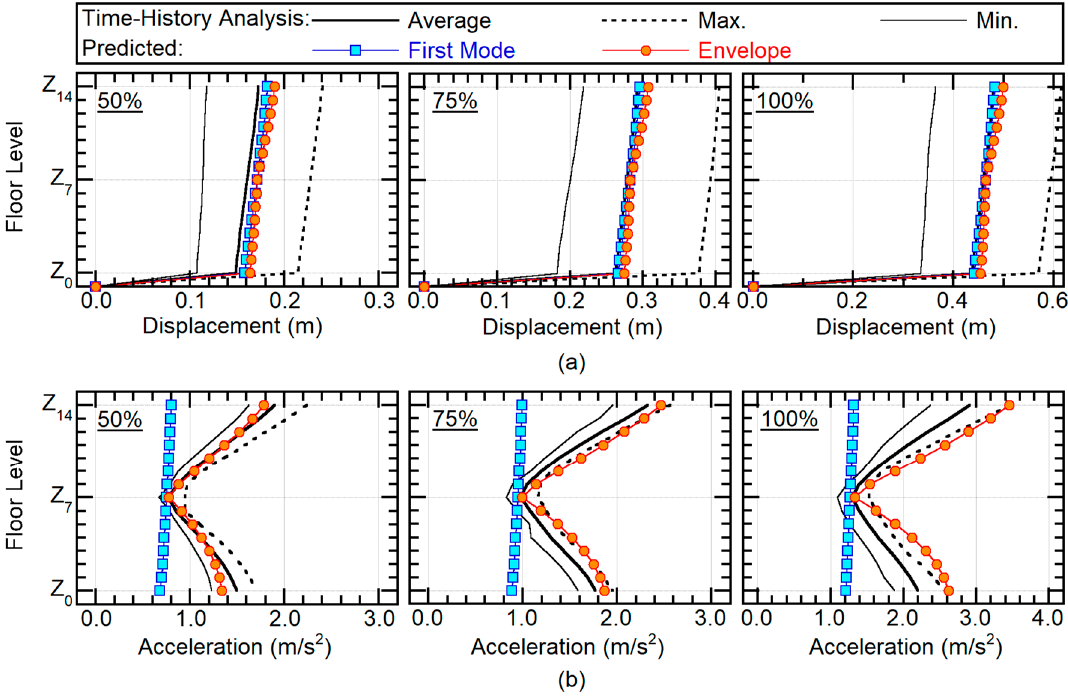
Figure 13. Comparisons of maximum floor response (Art-L series): ( a ) relative displacement; ( b ) absolute acceleration.